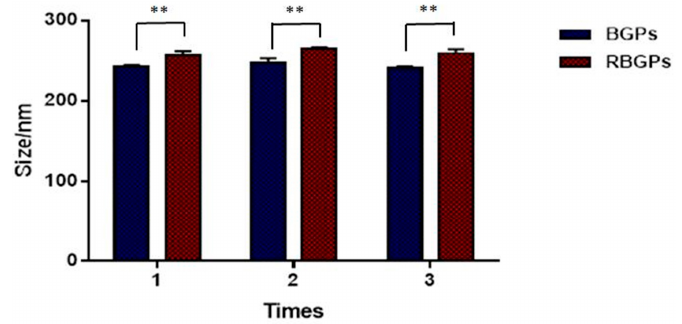
Figure 2. Size comparison between the BGPs and the RBGPs, repeated three times. Data are represented as mean ± SD, and “**” corresponds to p < 0.01.